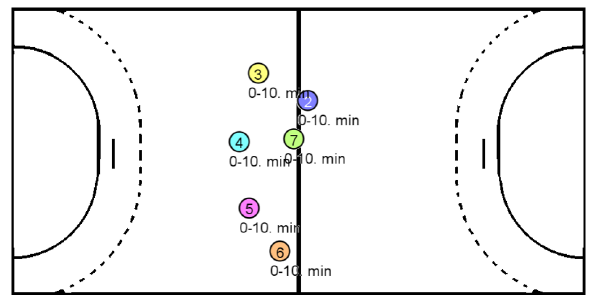
Figure 12. The RTL of the handball team. The constant change between offense and defense locates the players (colored dots) in the middle of the field. Figure 14. The detected changes using a less sensitive parameter setting. Only more significant changes